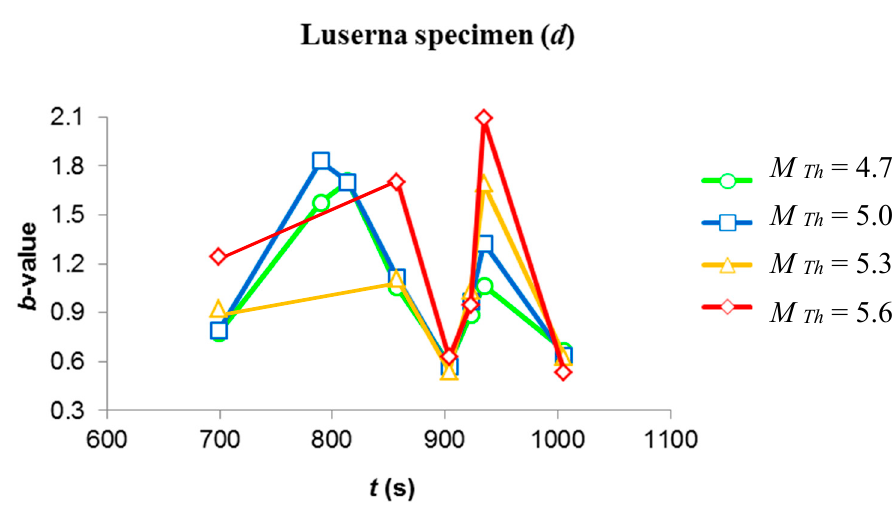
Figure 9. Trend of b-values for different threshold magnitudes. Trend lines of specimen ( c ) (upper panel) appear more self-similar than specimen ( d ) (lower panel).